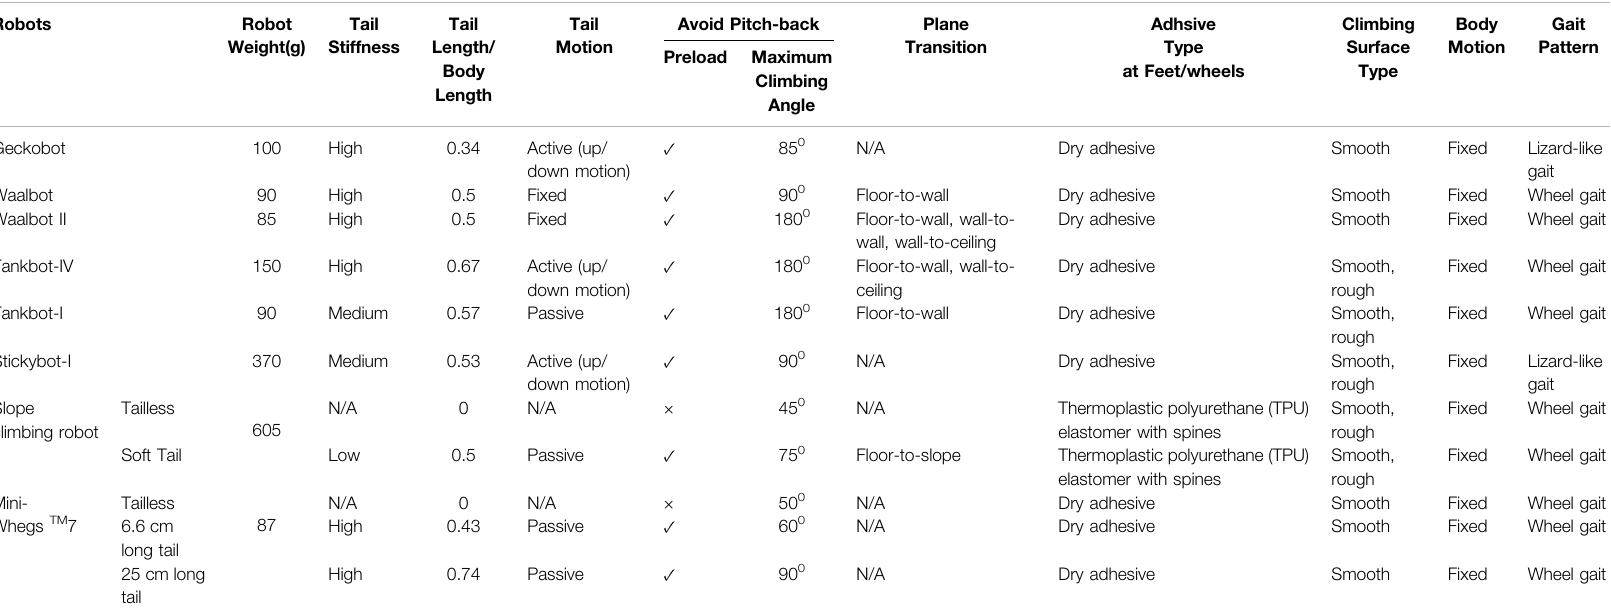
TABLE1| Characteristics ofgecko-inspired robotswithatail.Preloadmeansthattheloadgeneratedbythetailtopreventpitch-back. Lizard-like gaitmeansthattwodiagonal pairsoflegsswitchbetweenstance andswing phases. Wheel gait means that all four “ feet/wheels ” are attached to the surface all the time (i.e., stance